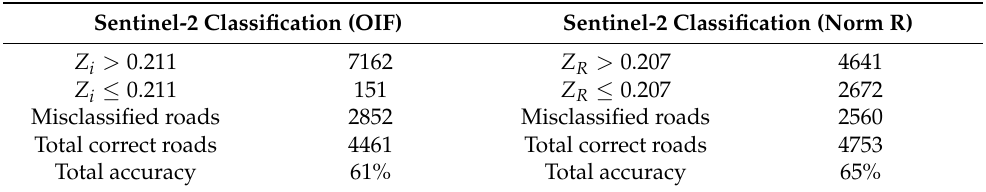
factor (OIF) and norm